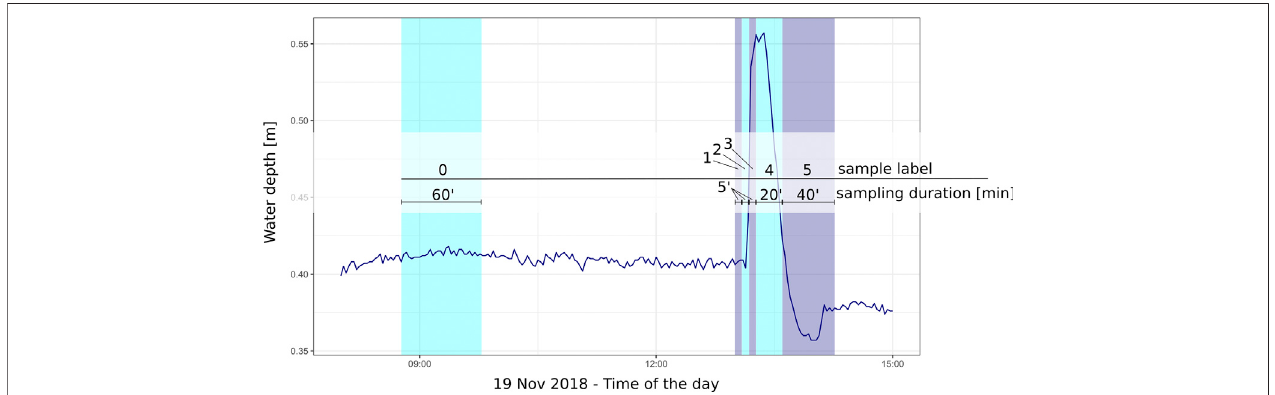
FIGURE 2 | Timing of the sampling (experimental peak 3 shown as example); the blue line represents the water depth recorded in the main channel at the downstream site during the experiment. Vertical coloured bands identify the six drift samplings performed. Once the 15 min peak ended, the hydropower plant would then re fi ll the storage volume, resulting in a water level lower than base fl ow conditions for approximately 30